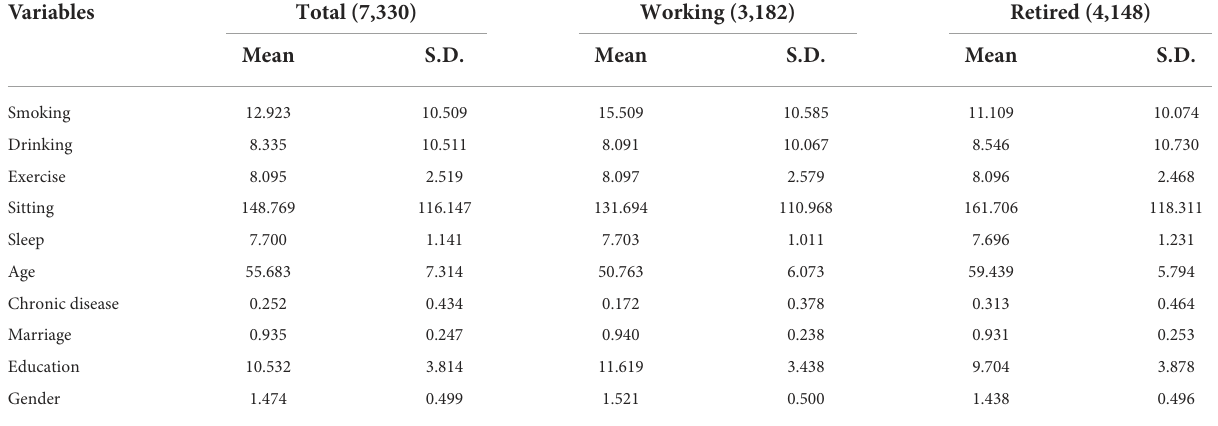
TABLE 1 Descriptive statistics.